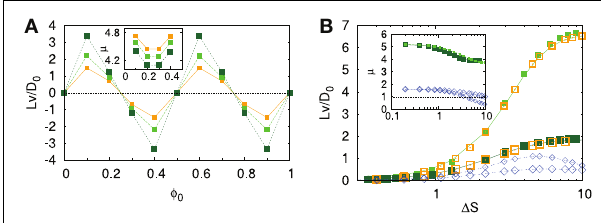
FIGURE 4 | Cooperative-rectification induced velocity of a Brownian motor under the action of a symmetric flashing ratchet and confined in a symmetric channel. (A) Normalized particle velocity, in units of D 0 / L with D 0 = D 0 ( R = 1 ) , upon variation of the phase shift φ 0 for different values of the parameter (cid:3) S = 1 . 73 , 2 . 19 , 2 . 94 (the larger the symbol size, the larger (cid:3) S ), with V 1 = 0 . 2 and Q = 2. Inset: μ as a function of φ 0 for the same parameters. (B) Normalized particle velocity upon variation of (cid:3) S for different particle radii R (solid lines, with h 0 = 1 . 25 , h 1 = 0 . 2), h 0 (solid points, with R = 1 , h 1 = 0 . 2) or h 1 (open points, with R = 1 , h 0 = 1 . 25) with φ 0 = 0 . 1 , 0 . 2 and V 1 = 0 . 2 , Q = 2 (the larger the symbol the larger φ 0 ). As a comparison the case with V 1 = 0 . 2 , Q = 0 . 02 and φ 0 = 0 . 1 , 0 . 2, (the larger the symbol the larger φ 0 )., is shown (blue diamonds). Inset: μ as a function of (cid:3) S for the same parameters. Reprinted with permission from (59). Copyright (2013) by the American Physical